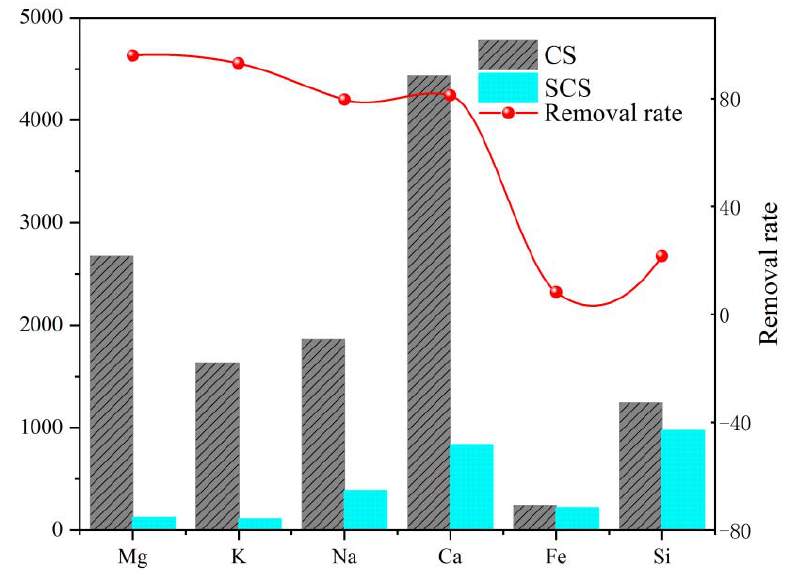
Figure 1. The fate of the metal elements CS, SCS. Table 1. The relative content of straw components.